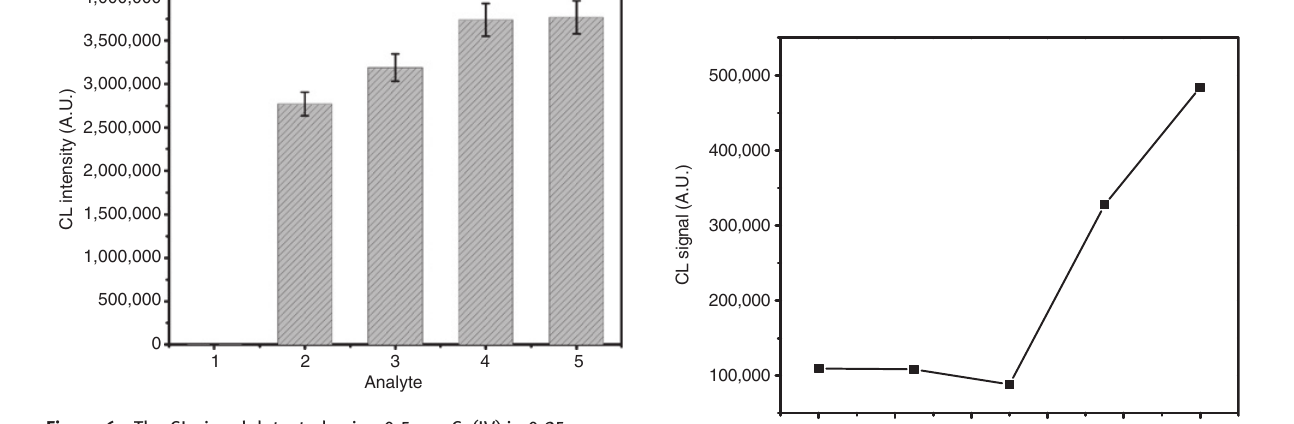
Figure 6: The CL signal detected using 0.5 mm Ce(IV) in 0.25 m sulfuric acid as oxidant and 1 mm oxalate as the analyte: 1, plain TiO NPs; 2, concentrated Ru(bpy) 32 + aqueous solution; 3, diluted 2 Ru(bpy) 32 + aqueous solution; 4, concentrated TiO 5, diluted TiO -Ru(bpy) 32 + NPs. 2